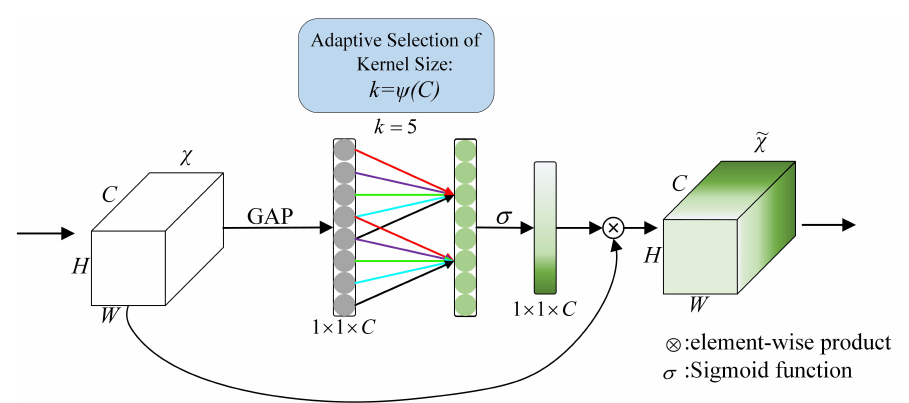
Figure 5. Structure of